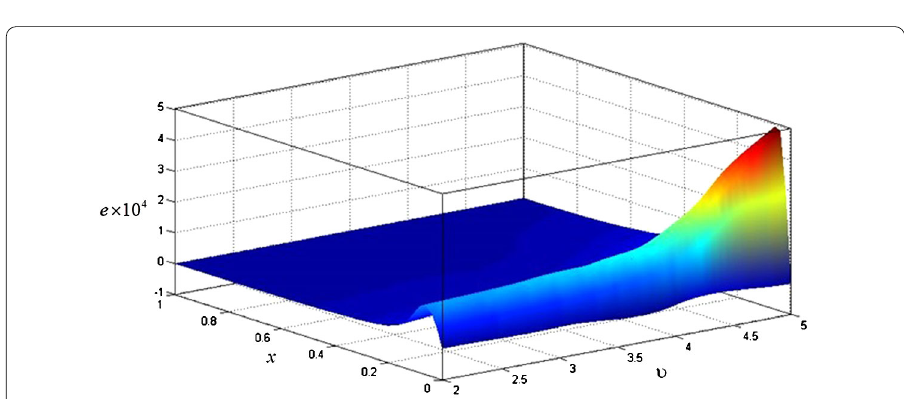
Figure 8 The strain distribution for a wide range of heat source speed when y = z =